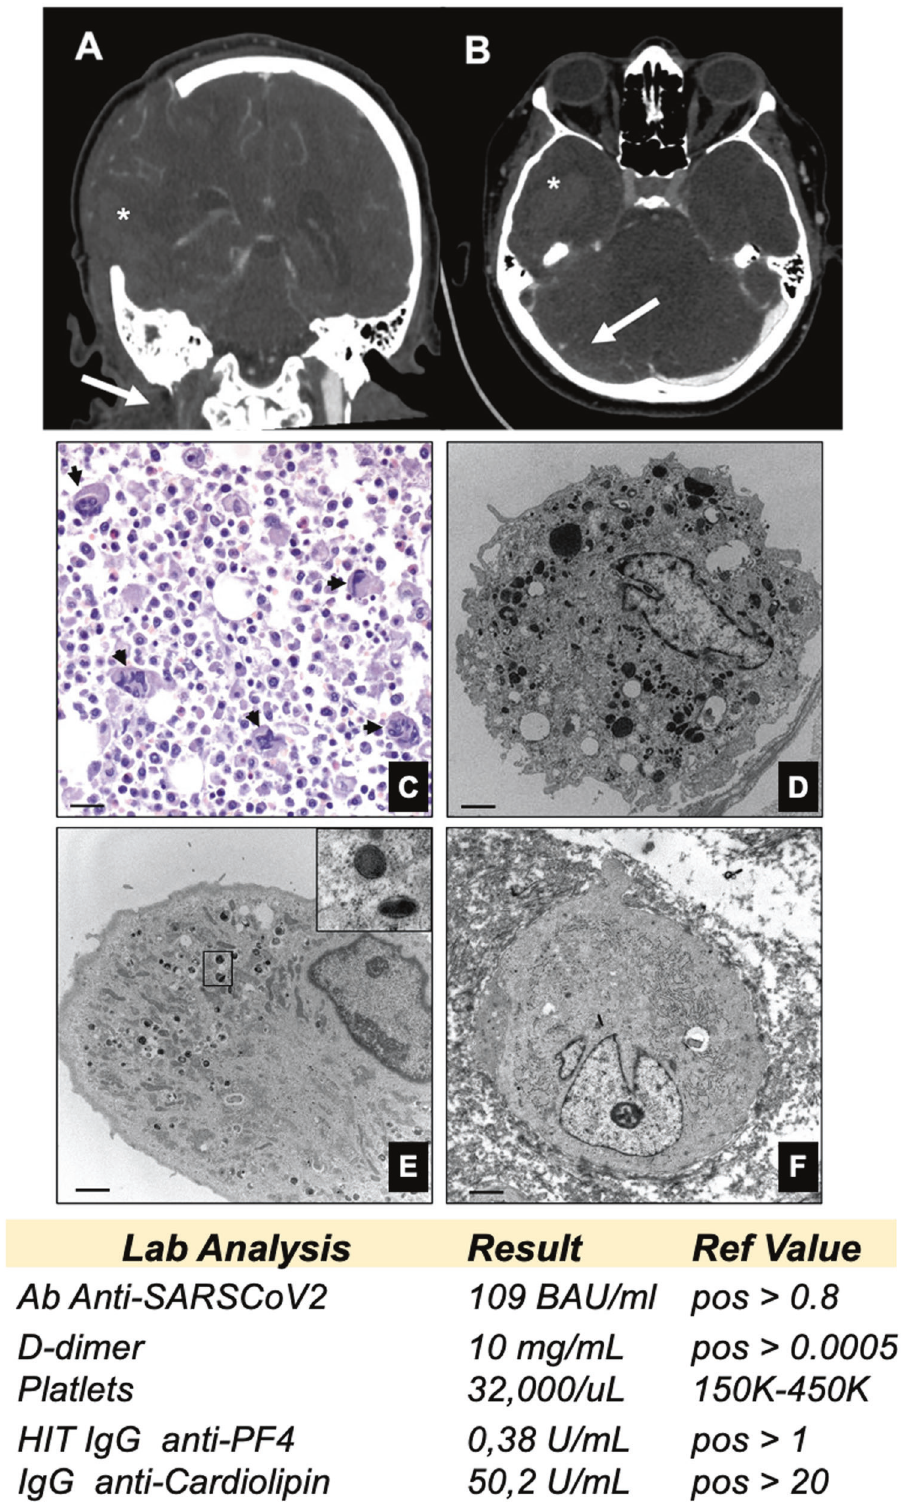
Fig. 1 Thrombosis and preexisting myelodysplasia. Computed tomography angiography (CTA); A coronal view shows right internal jugular vein thrombosis (arrow), B axial view shows right transverse sinus thrombosis (arrow). A massive hemorrhagic focus is observed on right hemisphere (*). C Hematoxylin and eosin stain shows numerous degranulated megakaryocytes (arrows) (scale bar 100 µm). D Normal megakaryocyte characterized by large and abundant cytoplasm with more than 50 mature platelet granules (scale bar 5 µm). E Electron micrograph displays a megakaryocyte with few mature platelet granules (square) and numerous mitochondria (scale bar 3 µm). F A completely degranulated megakaryocyte (scale bar 5 µm). Table reports laboratory test results (full results in Supplementary Table